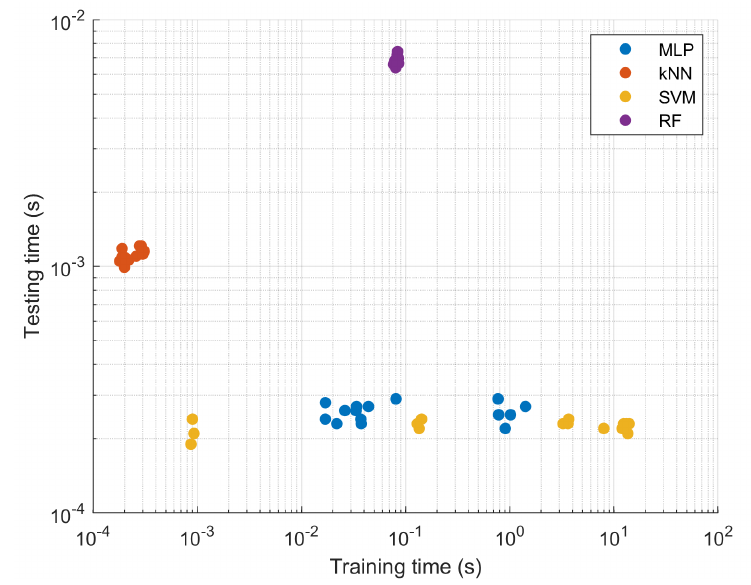
Figure 9. Comparison of classifiers based on training and testing